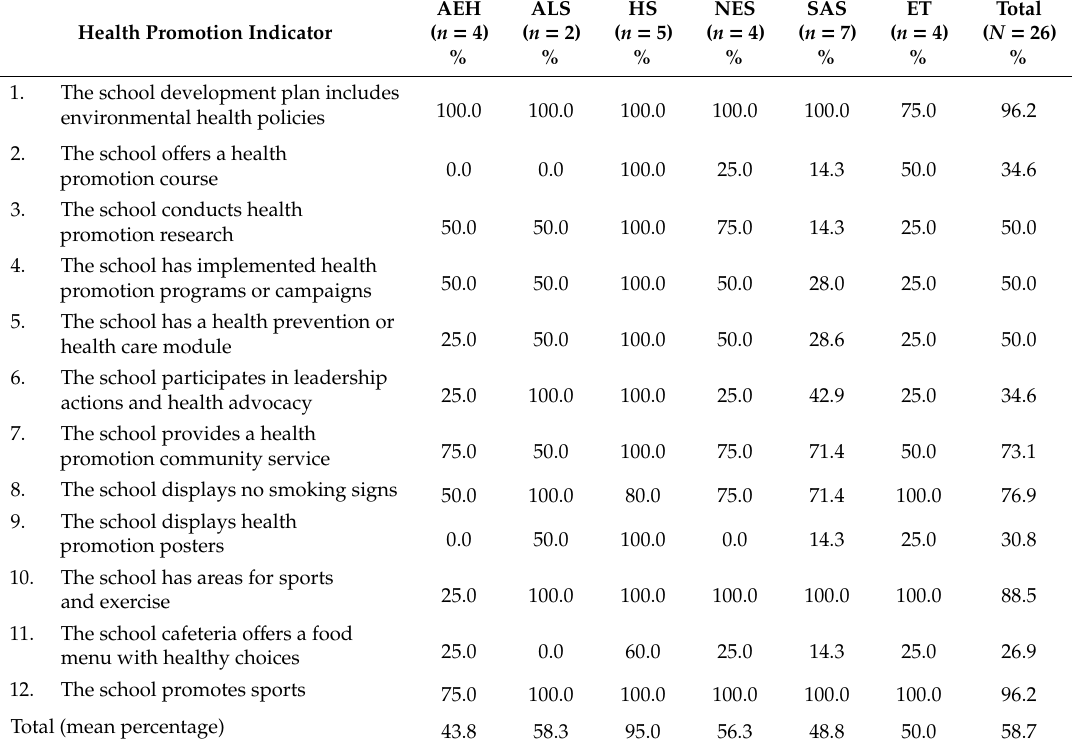
Table 3. Health Promotion Guidelines Compliance in Faculties According to Academic Discipline ( N =